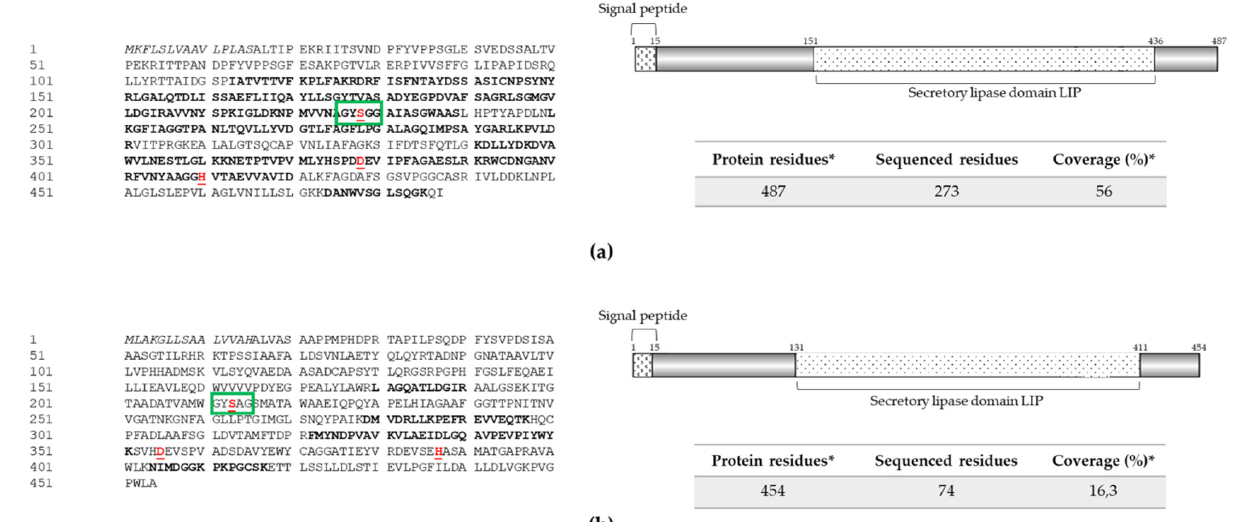
Figure 3. Extracellular lipases identified in protein extract from strain RGM 2184 culture supernatant in M2 and A8 media. ( a , b ) Sequences and scheme of exolipases Lip1 (OP328425) and Lip2 (OP328426), respectively. Exolipase sequences (left panel) were predicted from B. pseudobassiana RGM 2184 genome (JAKJXD000000000.1). Peptides sequenced by mass spectrometry are highlighted in bold (left panel). Relevant domains for these proteins (right panels) were detected though the NCBI conserved domains database. Signal peptide (italic), active site residues (underlined), catalytic triad (red), and relevant motive (green rectangles) are indicated in left and right panels, respectively. * indicate predicted information.